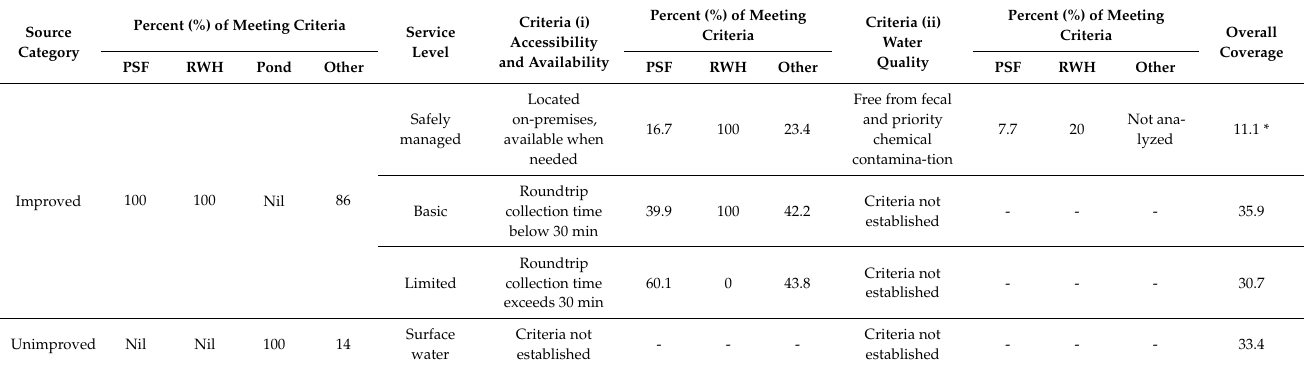
Table 6. Current coverage of drinking water services in Southkhali Union.